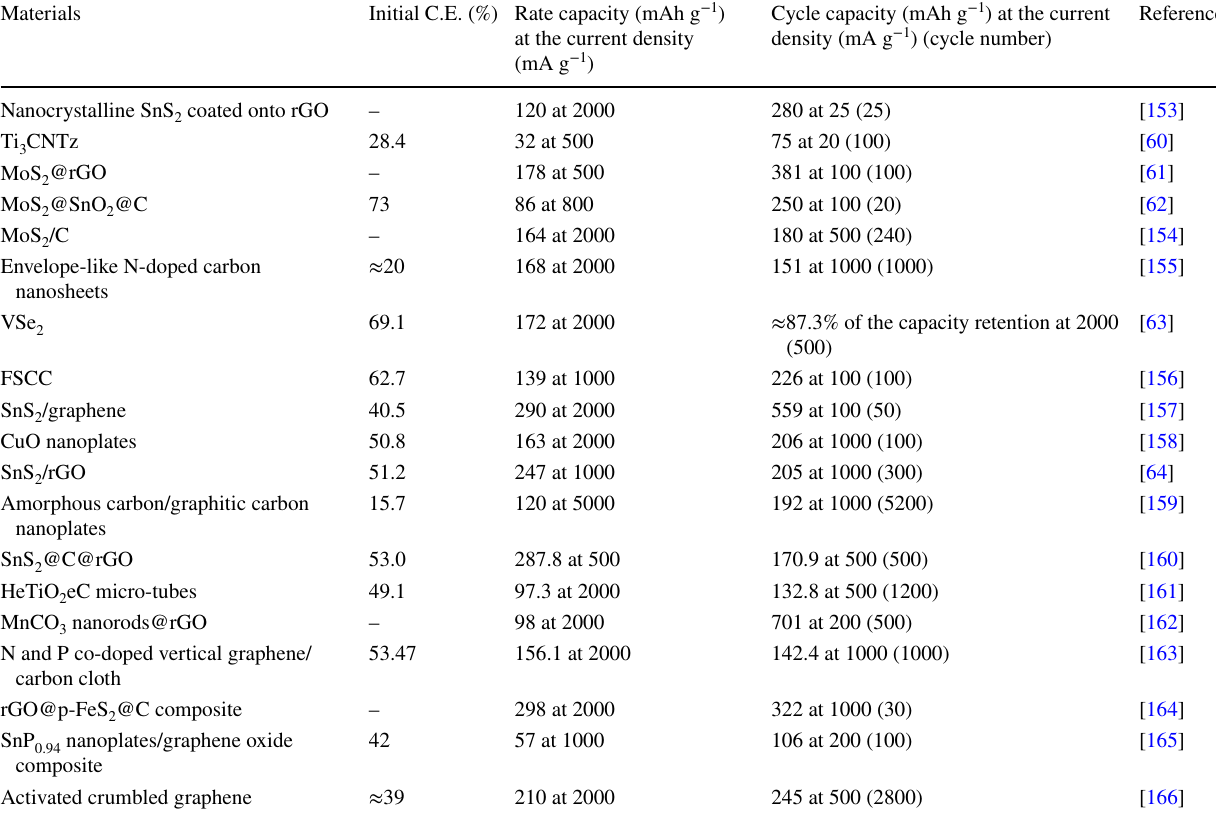
Table 3 Comparison of the state-of-the-art performances of 2D anode materials in PIBs